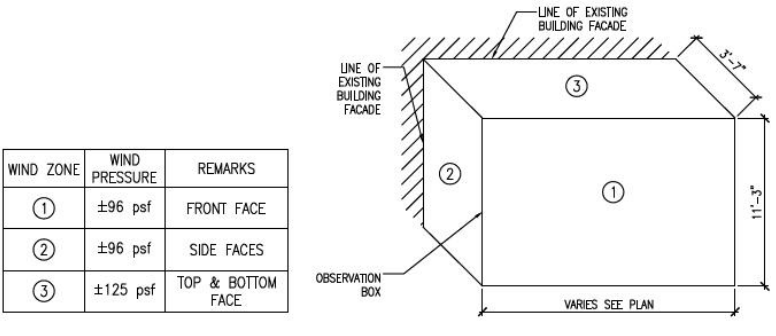
Figure 3: Design Wind